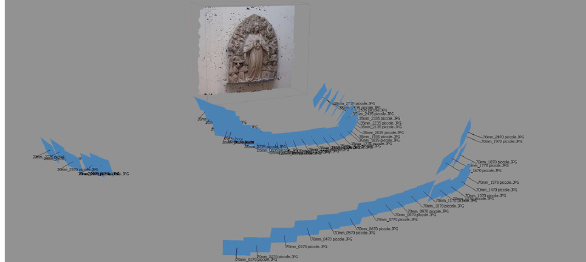
Figure 4: a screenshot of the Photoscan project